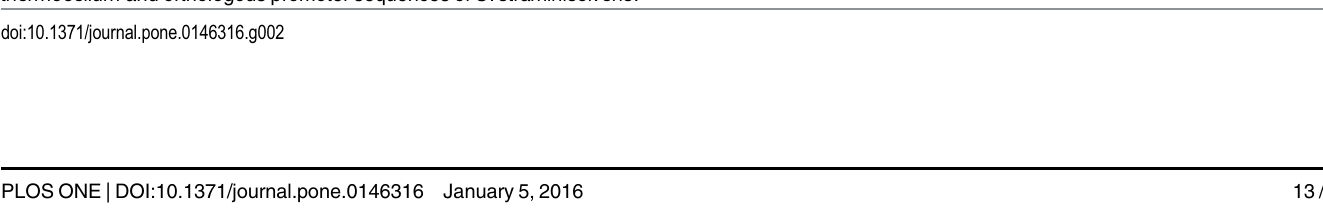
PLOS ONE | DOI:10.1371/journal.pone.0146316 January 5,